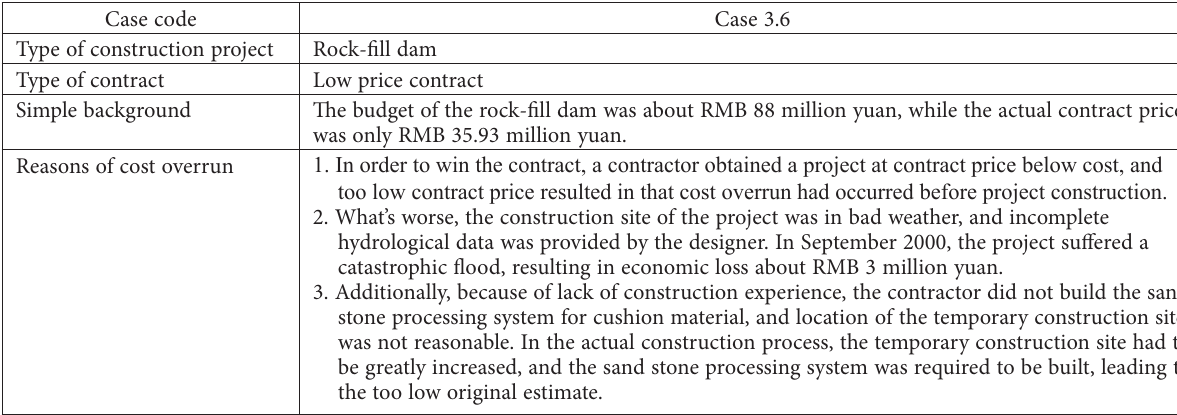
Table 2. Key information of Case 3.6